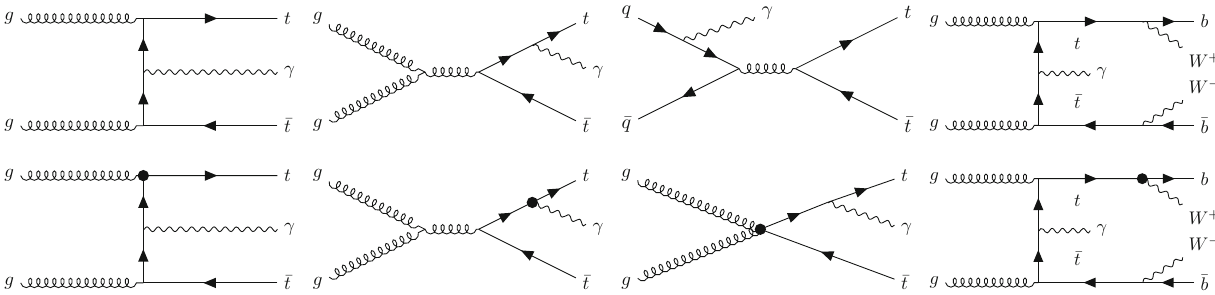
Fig. 1 Examples for Feynman diagrams contributing to t ¯ t γ production in pp -collisions in the SM (top) and including dimension-six operators (bottom). The black dot denotes the insertion of an effective operator from Eq. (2)